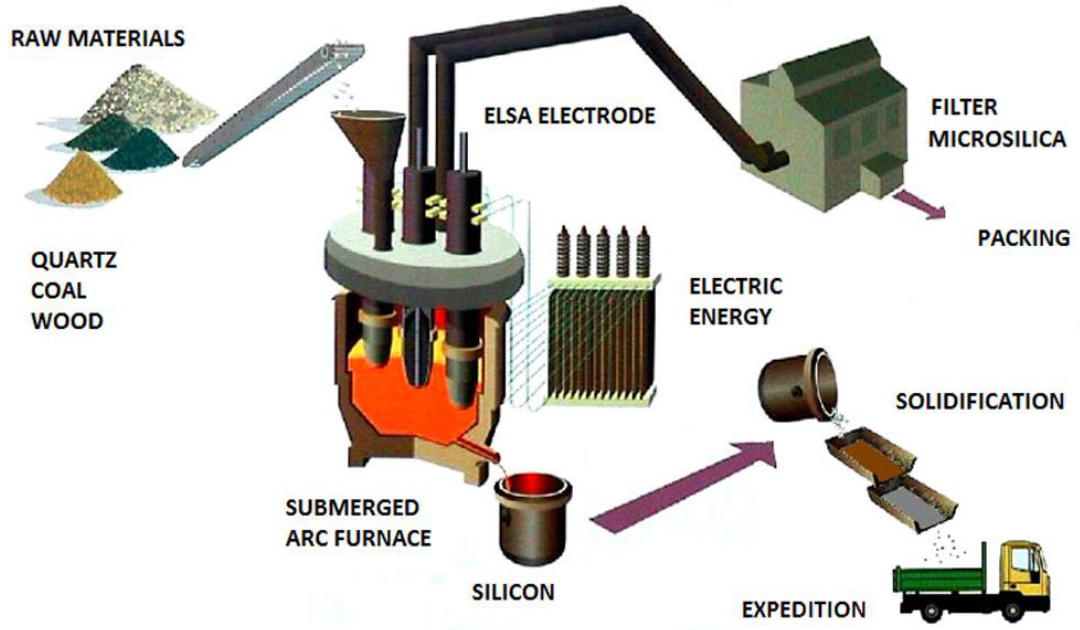
Figure 4. Me-Si production furnace and auxiliary facilities.